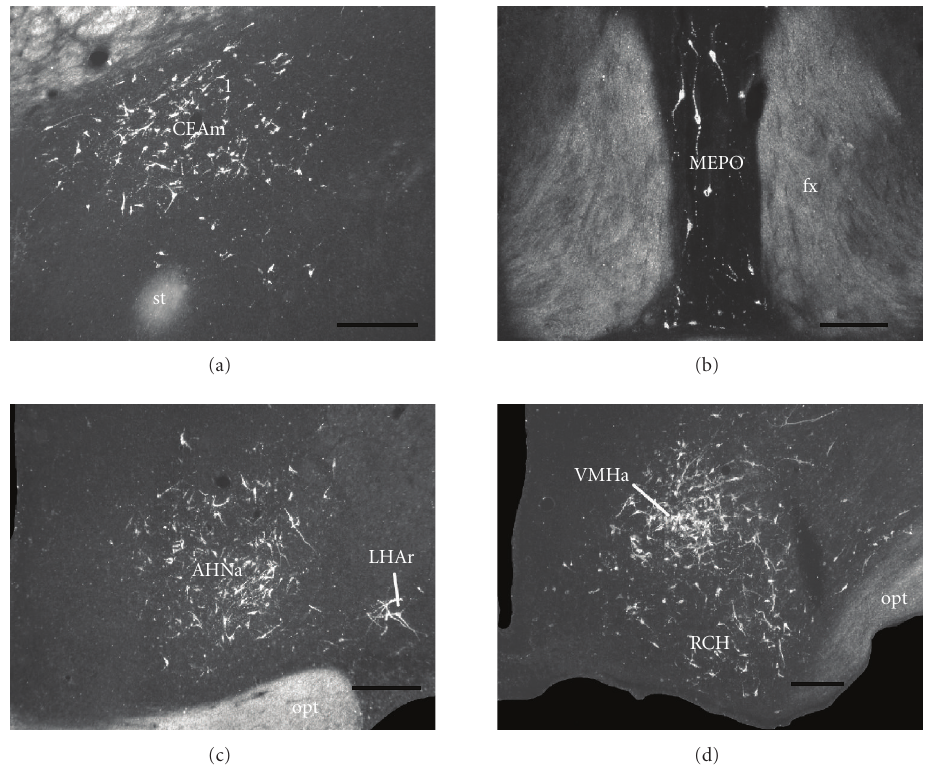
Figure 4: Dark field photomicrographs showing (a) the distribution of retrogradely labeled cells within the ipsilateral medial part of the central nucleus of the amygdala; (b) the median preoptic nucleus; (c) the anterior part of the anterior hypothalamic nucleus and the retinoceptive region of the lateral hypothalamic area; (d) and the anterior part of the ventromedial hypothalamic nucleus and the retrochiasmatic area. Scale bars = 200 µ